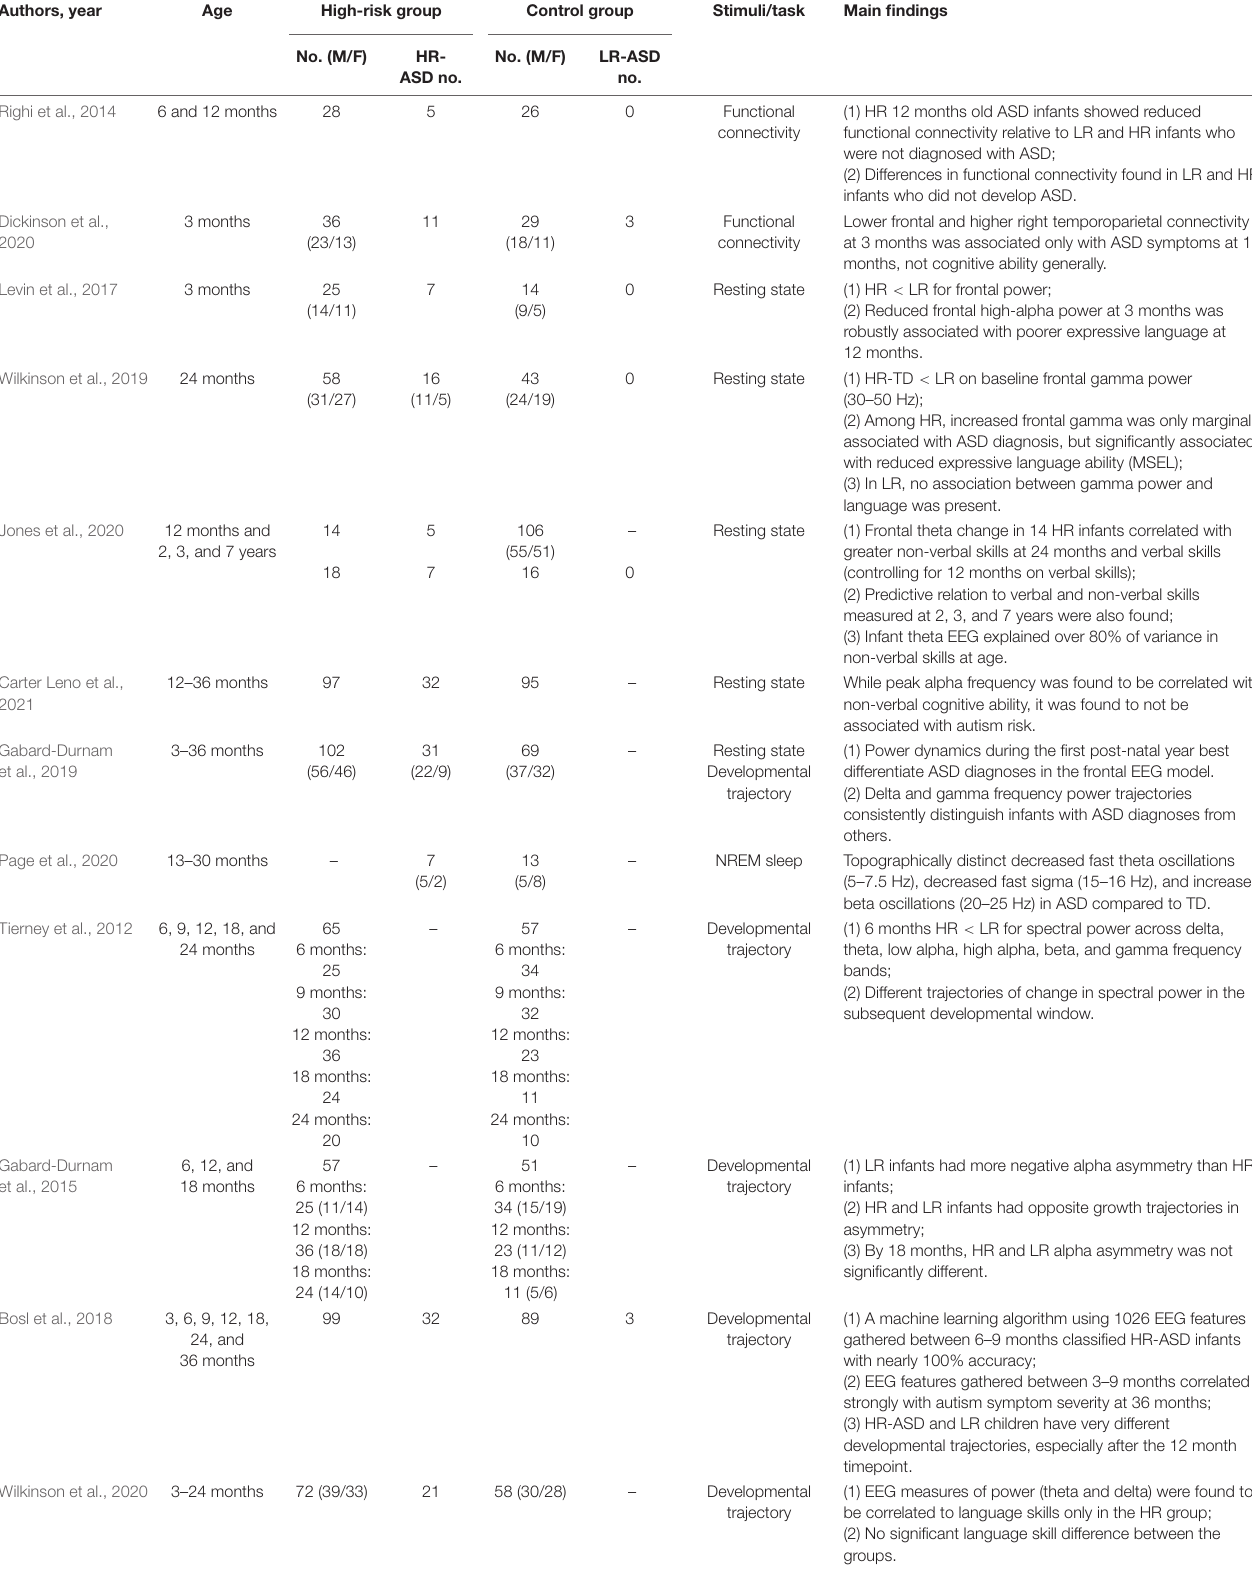
Developmental (1) LR infants had more negative alpha asymmetry than HR trajectory infants; (2) HR and LR infants had opposite growth trajectories in asymmetry; (3) By 18 months, HR and LR alpha asymmetry was not significantly different. (1) A machine learning algorithm using 1026 EEG features gathered between 6–9 months classified HR-ASD infants with nearly 100% accuracy; (2) EEG features gathered between 3–9 months correlated strongly with autism symptom severity at 36 months; (3) HR-ASD and LR children have very different developmental trajectories, especially after the 12 month timepoint. (1) EEG measures of power (theta and delta) were found to be correlated to language skills only in the HR group; (2) No significant language skill difference between the